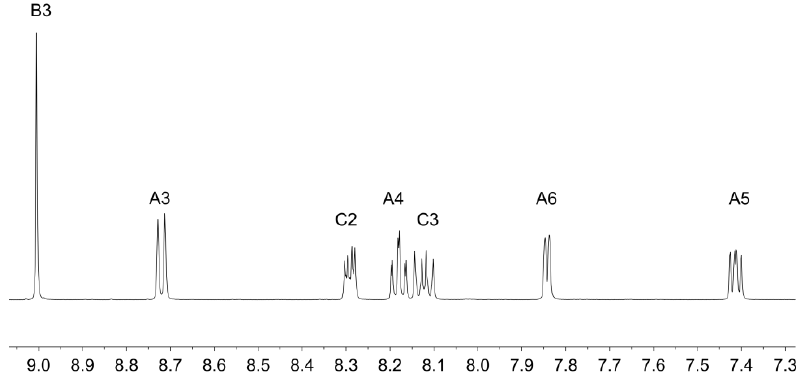
Figure 2. The 1 H NMR spectrum (500 MHz, CD 3 CN) of [Zn( 2 ) 2 ][CF 3 SO 3 ] 2 (see also Figure S6). See Scheme 2 for atom labels.